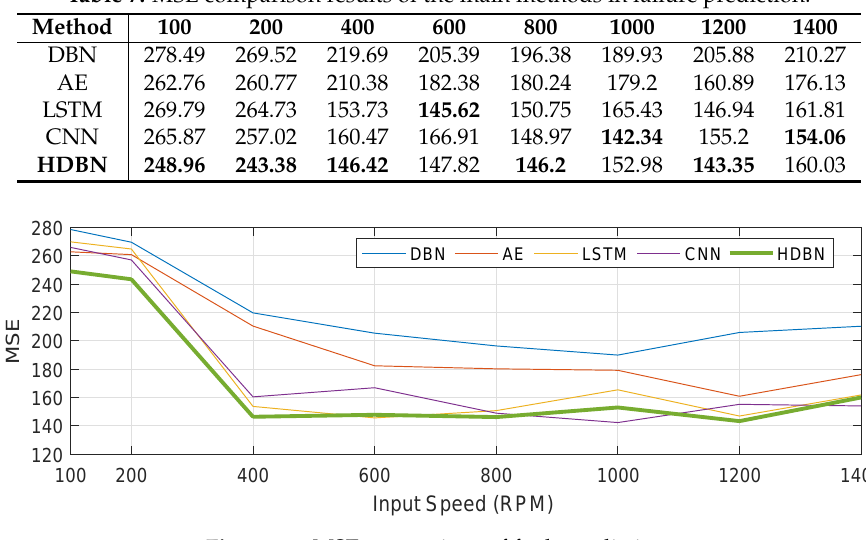
Figure 16. MSE comparison of fault